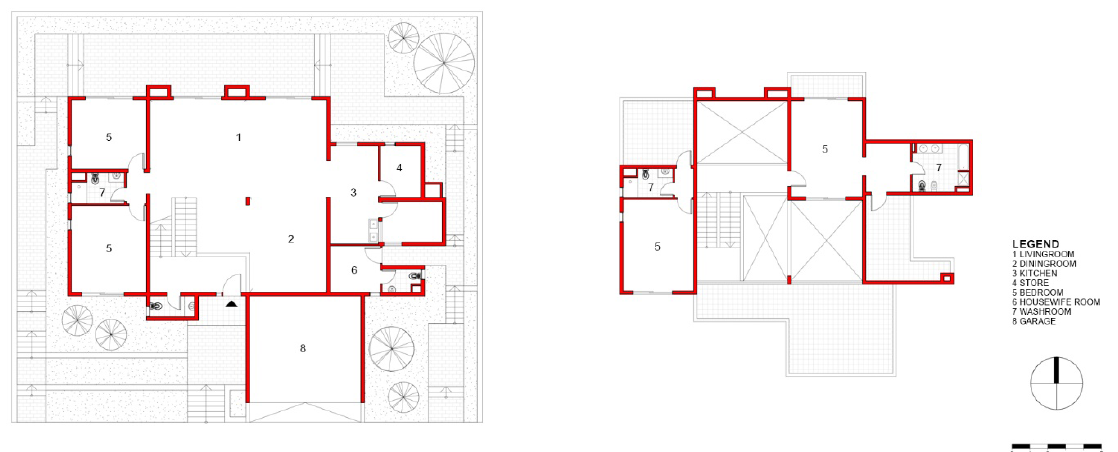
Figure 52. The Umudugudu Kigali Vision: Ground and first floor, 4-bedrooms Villa. Drawing by Manlio